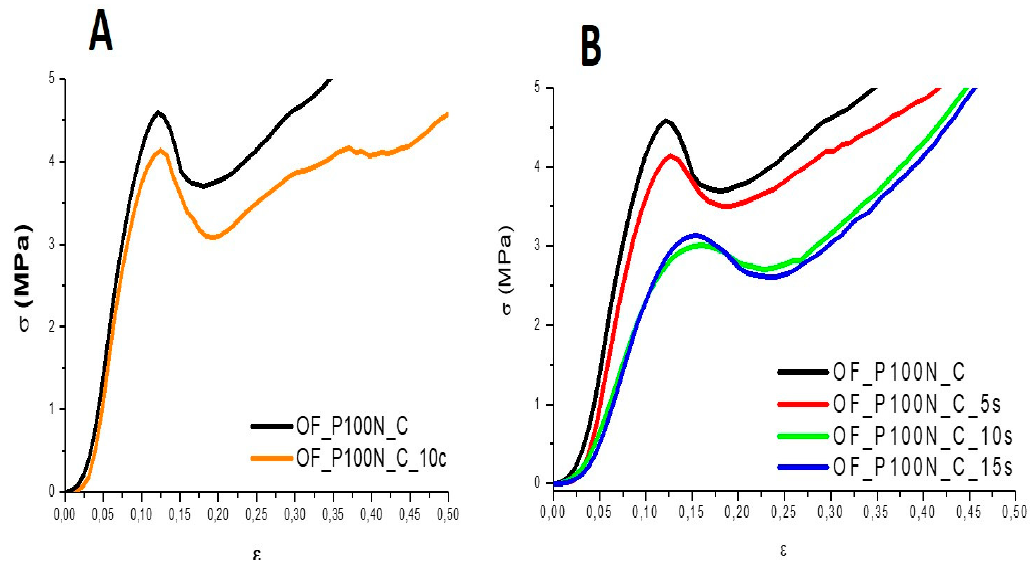
Figure 4. ( A ) Stress-strain curves of OF_P100N_C with and without coffee powder; ( B ) stress-strain curves of OF_P100N_C with a different amount of sawdust.